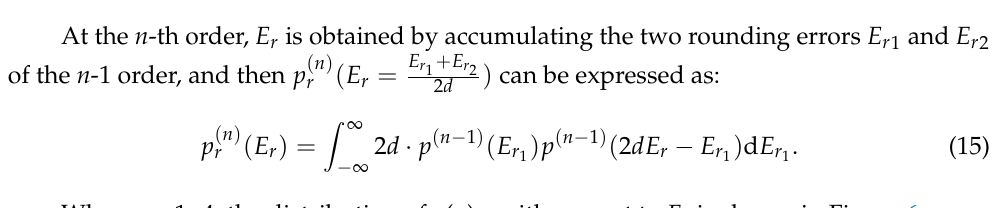
Figure 6. When n = 1~4, the distribution of p ( n )